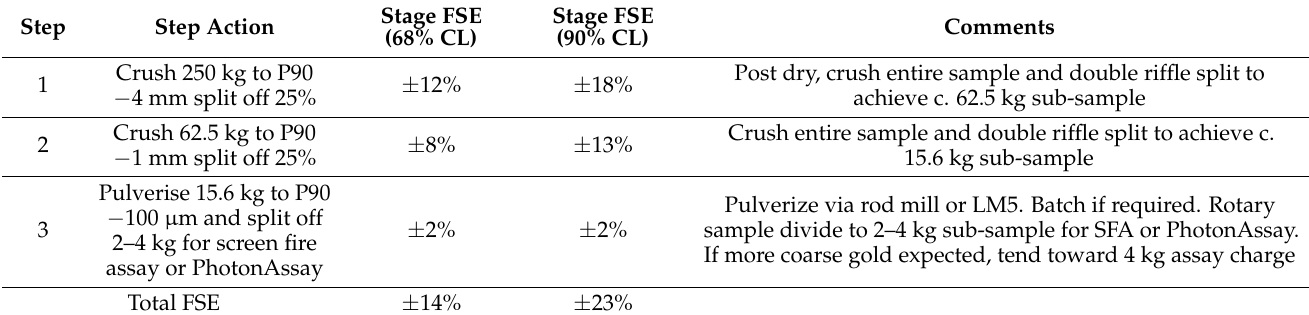
Table 4. Potential sample preparation and assay protocol based on reducing a 250 kg sample to 2.5 kg for assay. The FSE values are rounded to the nearest whole %. The FSE calculation is based on a grade of 10 g/t Au, liberation diameter of 1 mm, and nominal material size of 5 cm (assuming dominant concentration of gold in the − 5 cm fraction). This protocol accounts for coarse gold, hence a large liberation